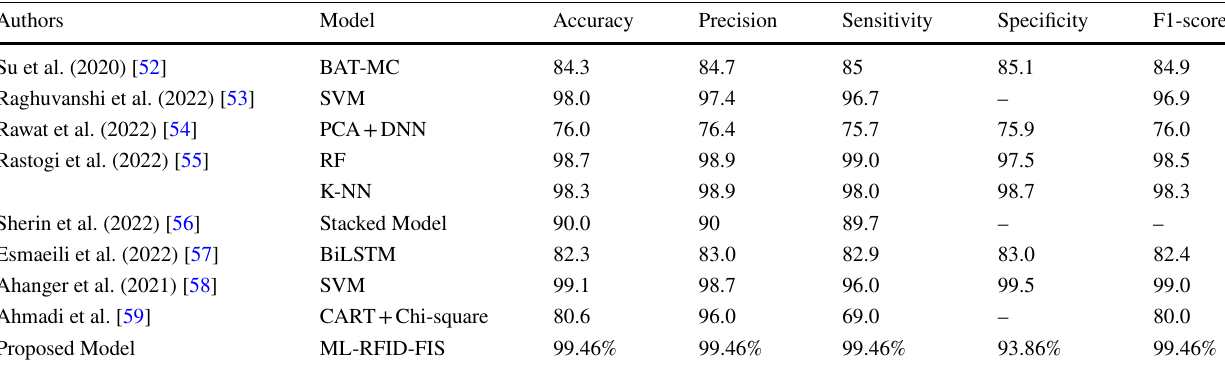
Table 17 The comparison of the proposed model with other existing models using the same dataset Authors Model Accuracy Precision Sensitivity Specificity